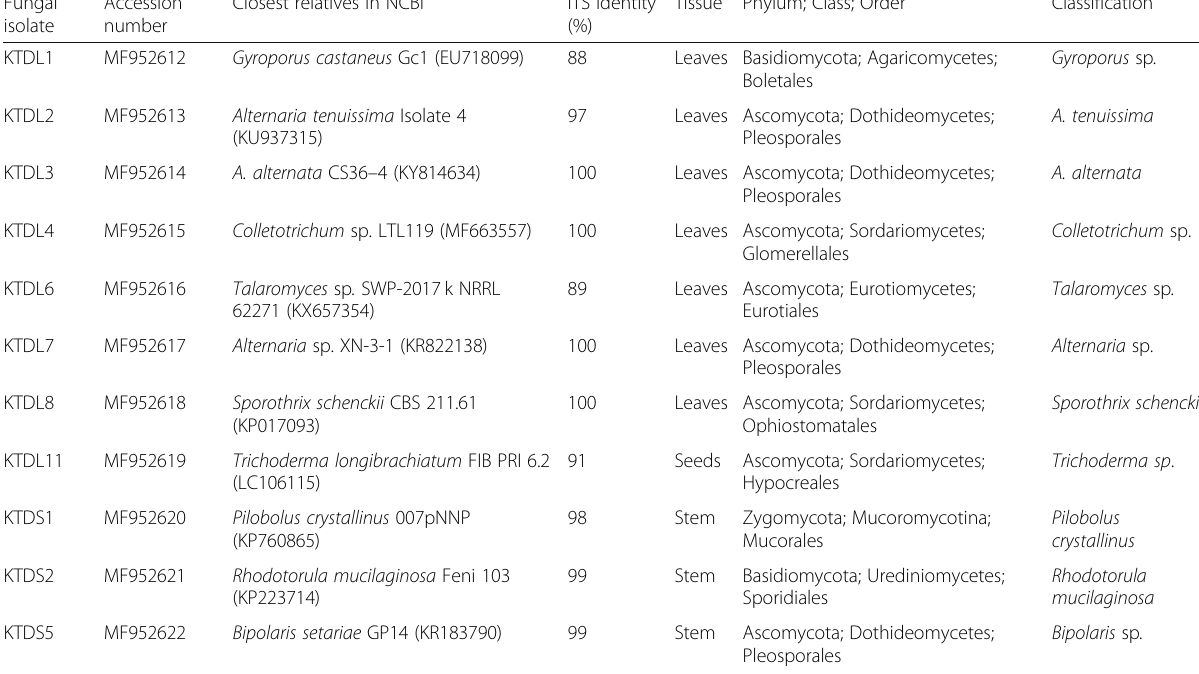
Table 1 Eleven fungal endophytes isolated from D. stramonium Fungal isolate